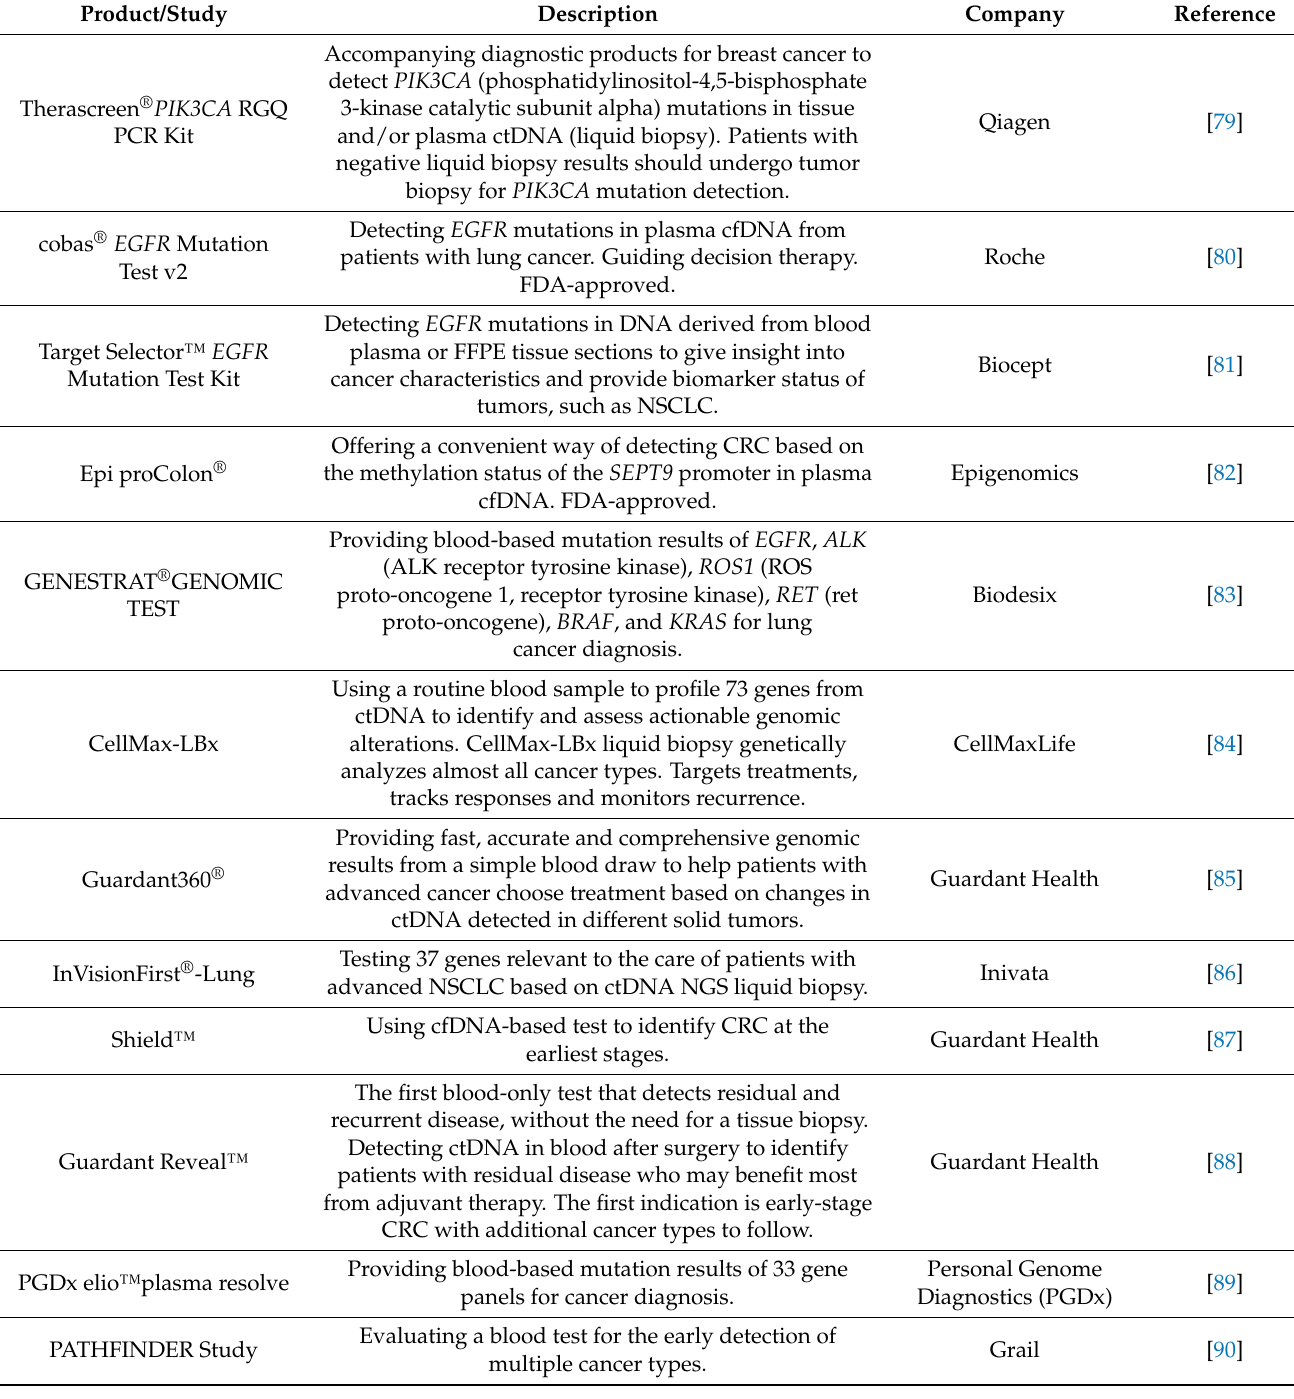
Table 2. cfDNA liquid biopsy